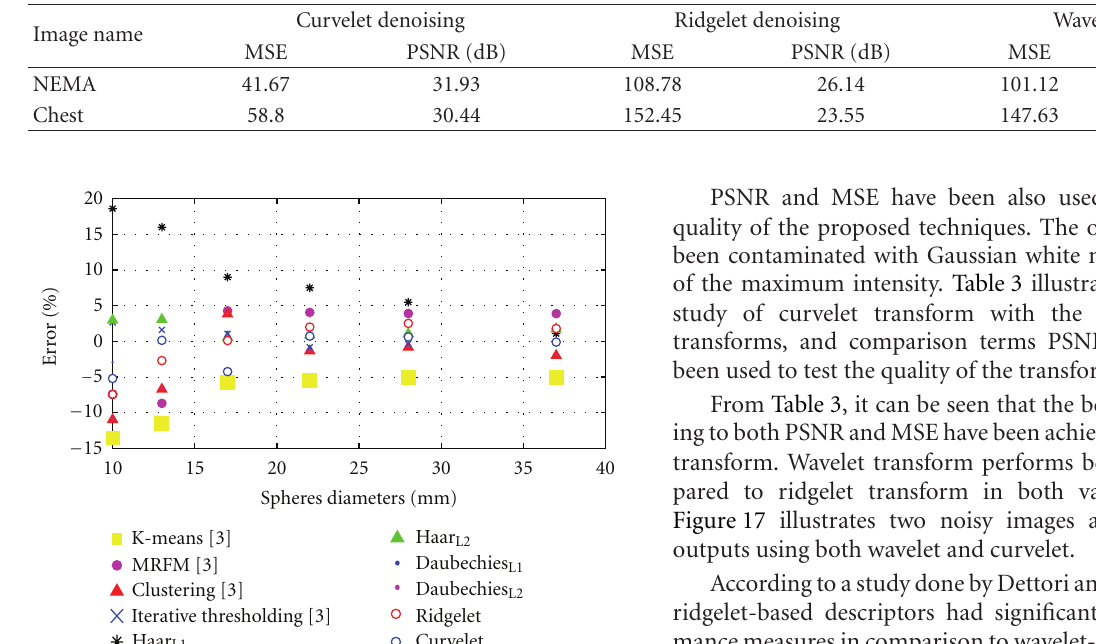
Table 3: Comparison of curvelet, ridgelet, and wavelet denoising in terms of PSNR and MSE.